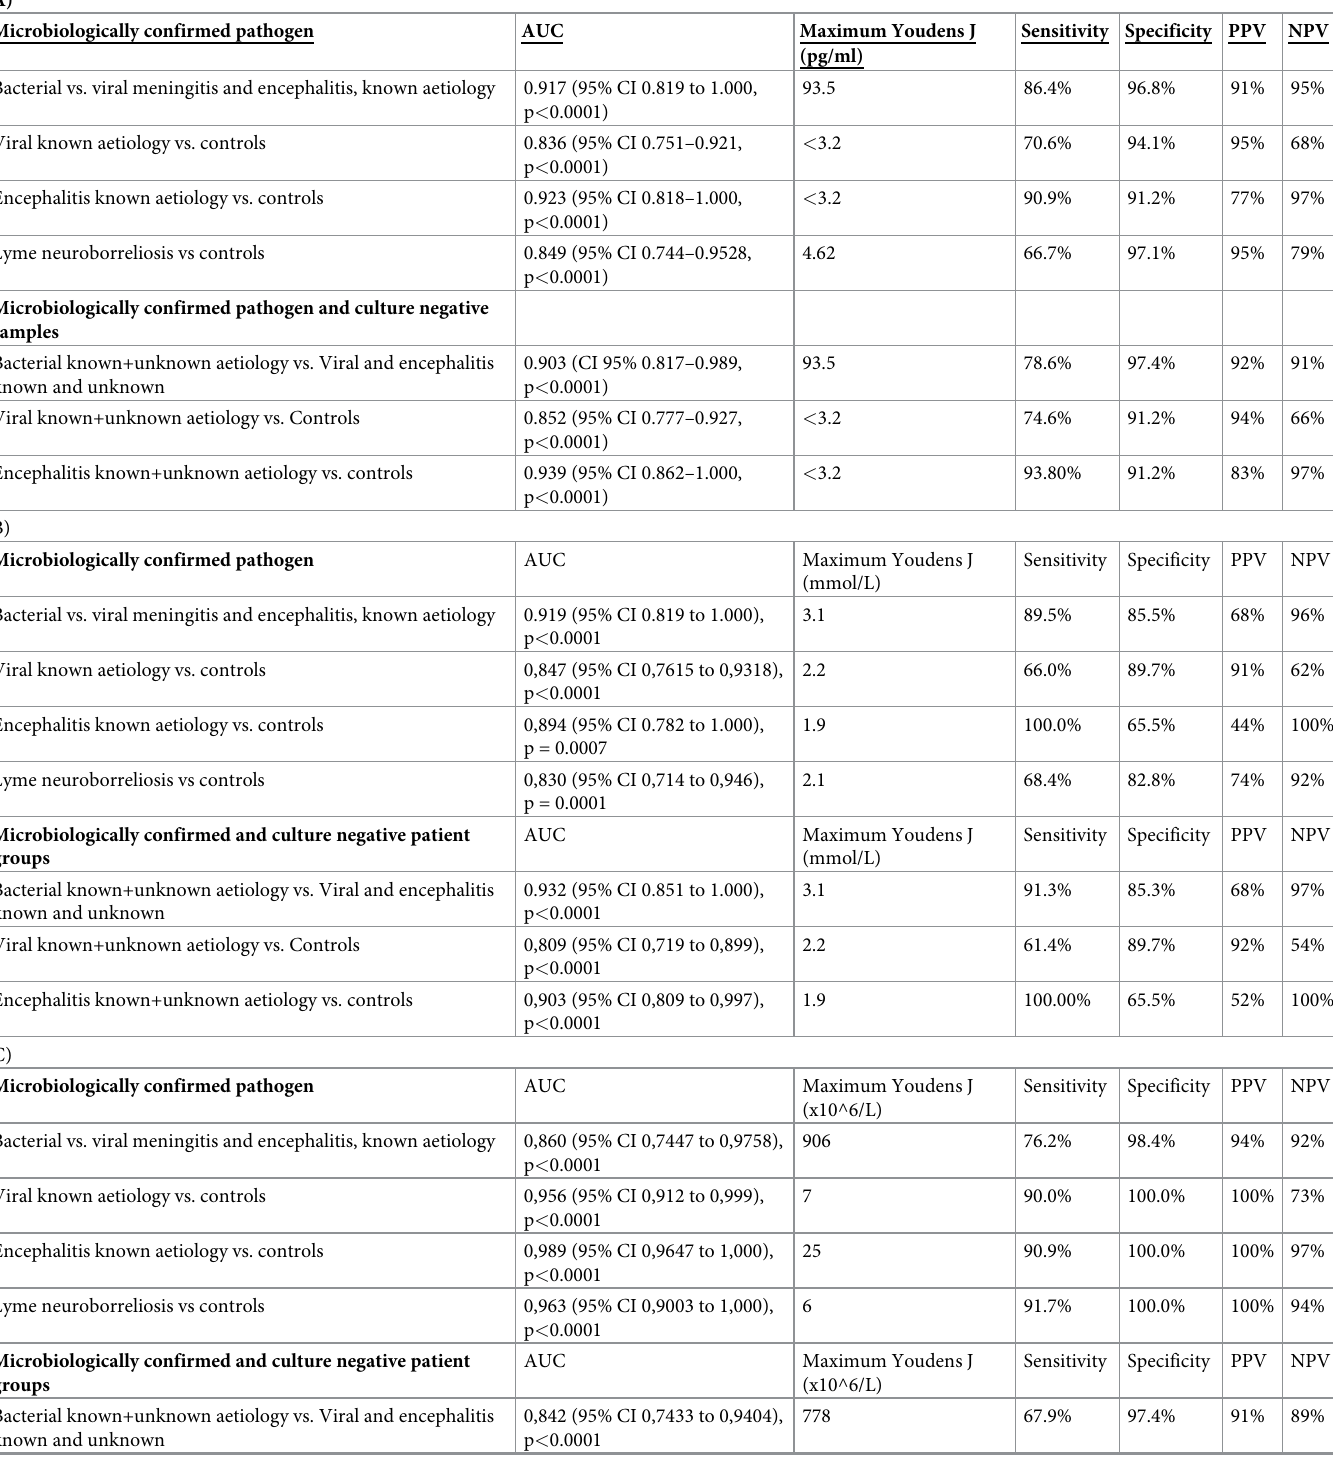
Table 4. Table of AUC, Youdens J, sensitivity, specificity and predictive values. A) PTX3, B) lactate and C) leukocyte cell count in the CSF for diagnosing CNS